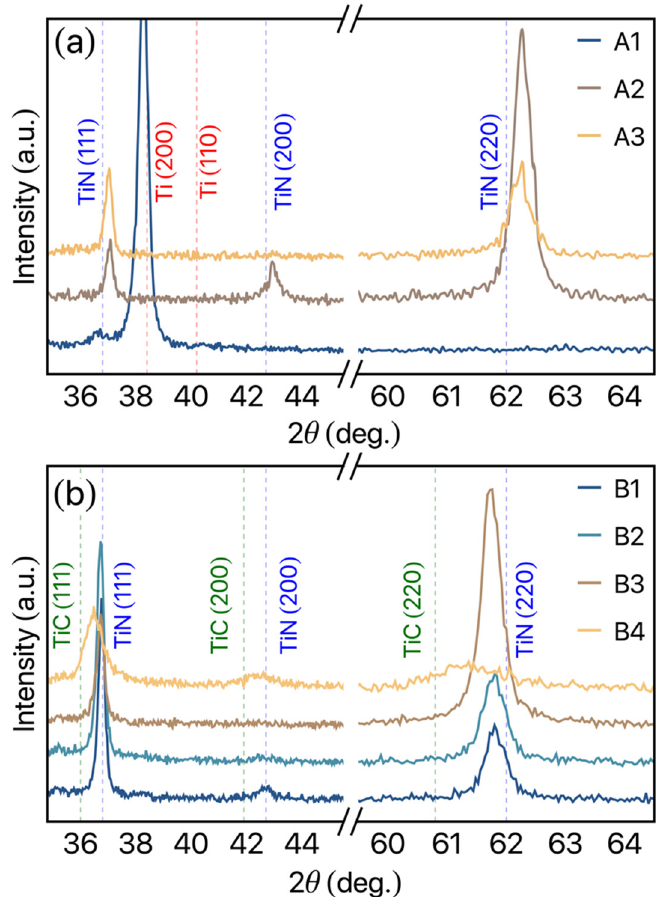
Figure 2. X-ray diffraction pattern for the ( a ) TiN films and ( b ) Ti (N, C) films. The peaks were indexed by using the ICSD cards no. 253,841, 64,906 and 44,494 for the Ti, TiN, and TiC phases, respectively.